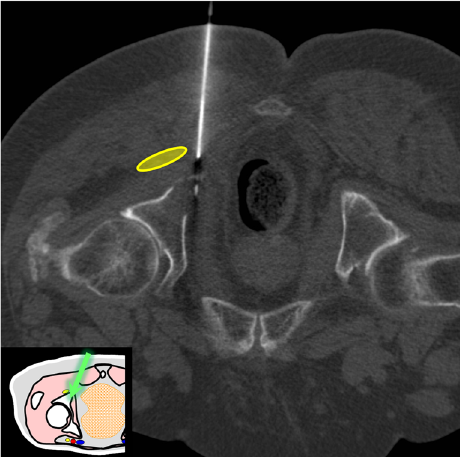
Fig. 17 An 80-year-old woman with clinical background of clear cell renal carcinoma presenting with a new lytic lesion at the ischial spine. A posterior approach, medial to the sciatic nerve, was used to perform biopsy with a coaxial 16-G cutting needle, which confirmed clear cell renal carcinoma metastasis